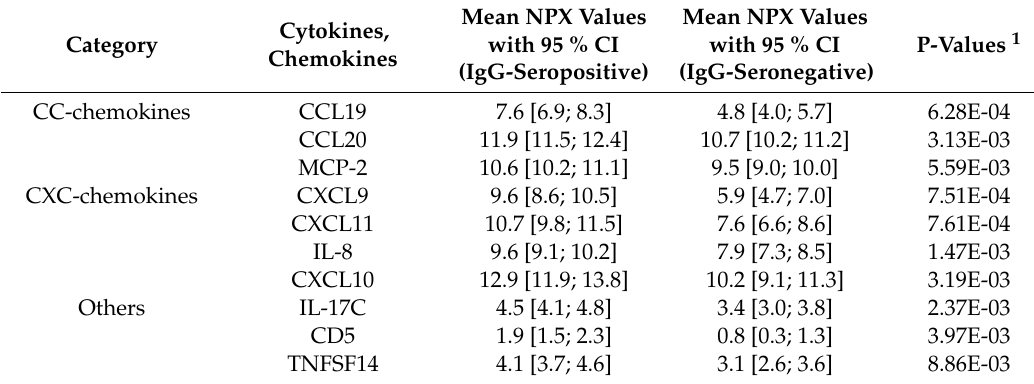
Table 2. Breast milk cytokine / chemokine concentrations [Normalized Protein Expression, Olink] —proteins with significant di ff erences.